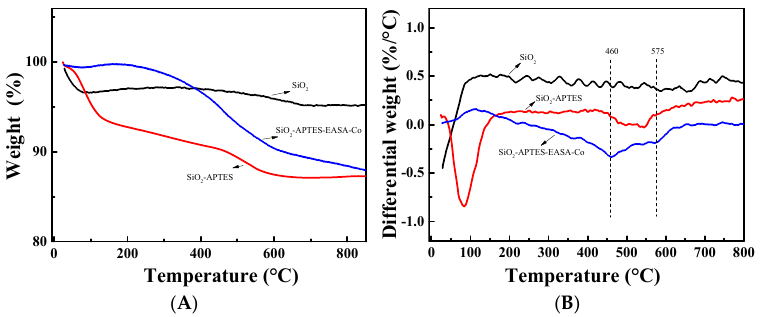
Figure 5. TGA ( A ) and DTG ( B ) curves of the support SiO 2 , the intermediate SiO 2 ‐ APTES and the covalently anchored catalyst SiO 2 ‐ APTES ‐ EASA ‐ Co.